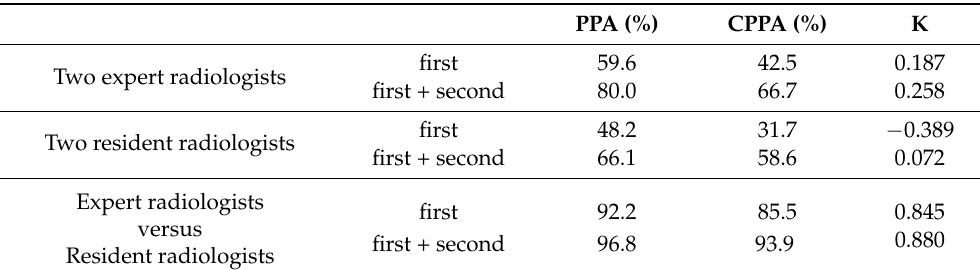
Table 4. Three inter-reader agreements for identifying the true MR images for each reader, including the expert and resident